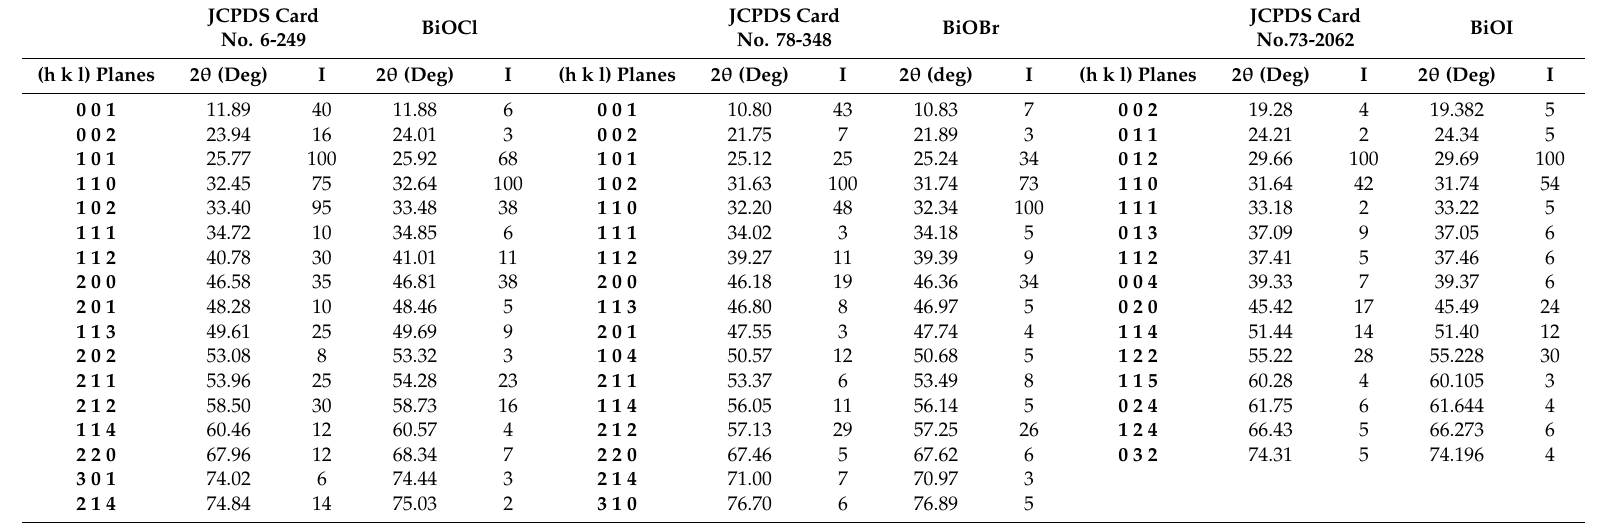
JCPDS: Joint Committee on Powder Di ff raction Standards. Table 3. XRD data of the photocatalysts based on bismuth